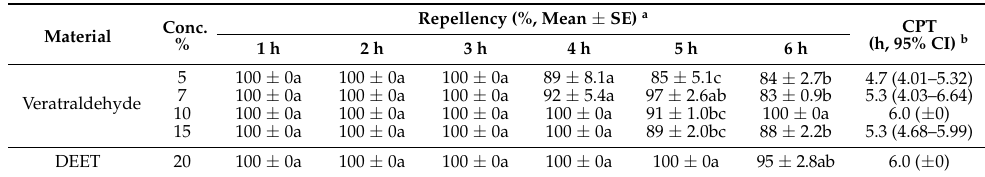
Table 4. Repellency and CPT based on the concentrations of veratraldehyde against Culex pipiens pallens females using the arm-in-cage test.